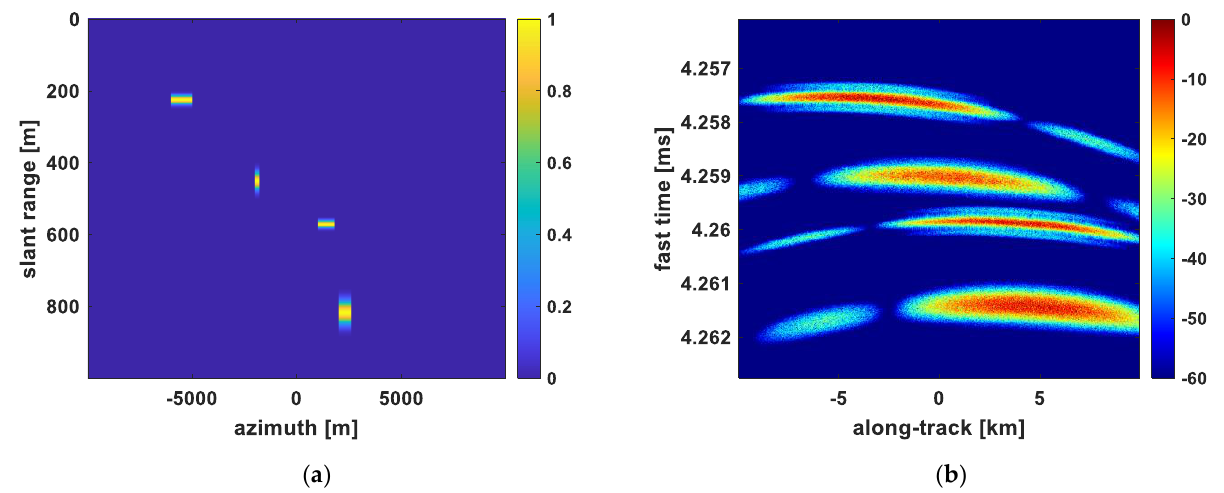
Figure 12. ( a ) Map of the distributed target backscatter in the slant range, azimuth domain, where color corresponds to backscatter coefficient in linear scale. ( b ) Intensity, in dB, of one range com- pressed simulated image.